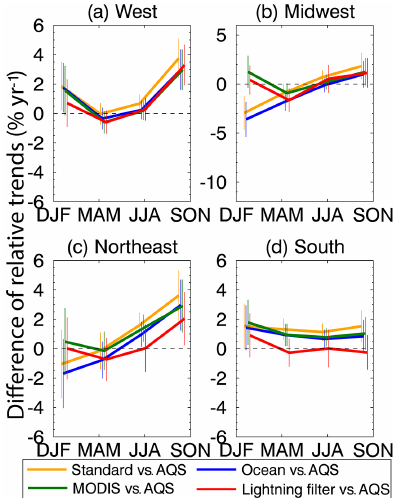
Figure 7. Seasonal differences of OMI-based relative trends from those computed from AQS in situ data. The error bars represent 95th-percentile confidence intervals. The relative trends are shown in Figs. 4 and 6. The figure legends are the same as in Figs. 4 and 6 but with the AQS trends subtracted from the OMI-based